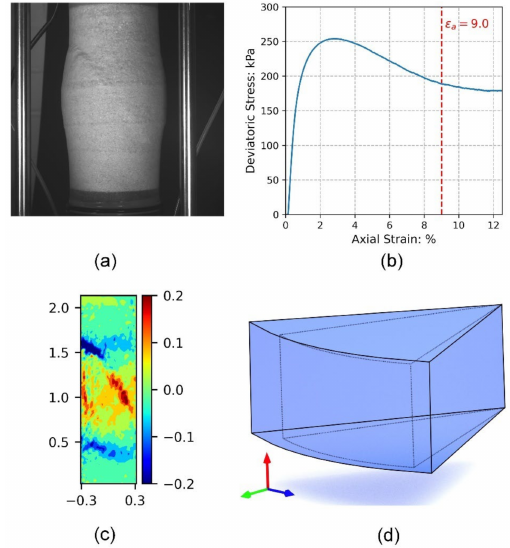
Figure 5. An example of a divergence field of test 092903b at axial strains between ε a = 0.0% and ε a = 9.0%: ( a ) specimen image at an axial strain of ε a = 9.0%; ( b ) stress– strain curve of the test and strain moment of ε a = 9.0%; ( c ) divergence field calculated between ε a = 0.0% and ε a = 9.0%; ( d ) schematic illustration of the positive divergence field in cylindrical